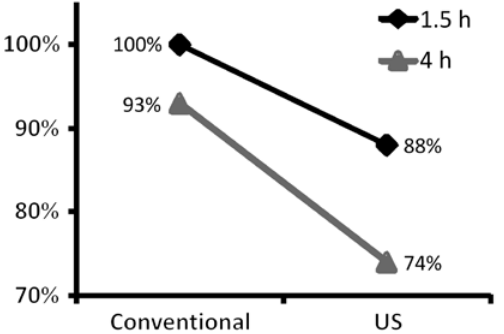
Figure 3: Graphical representation of the interaction effect between time reaction (1.5 h to 4 h) and methodology (conventional and